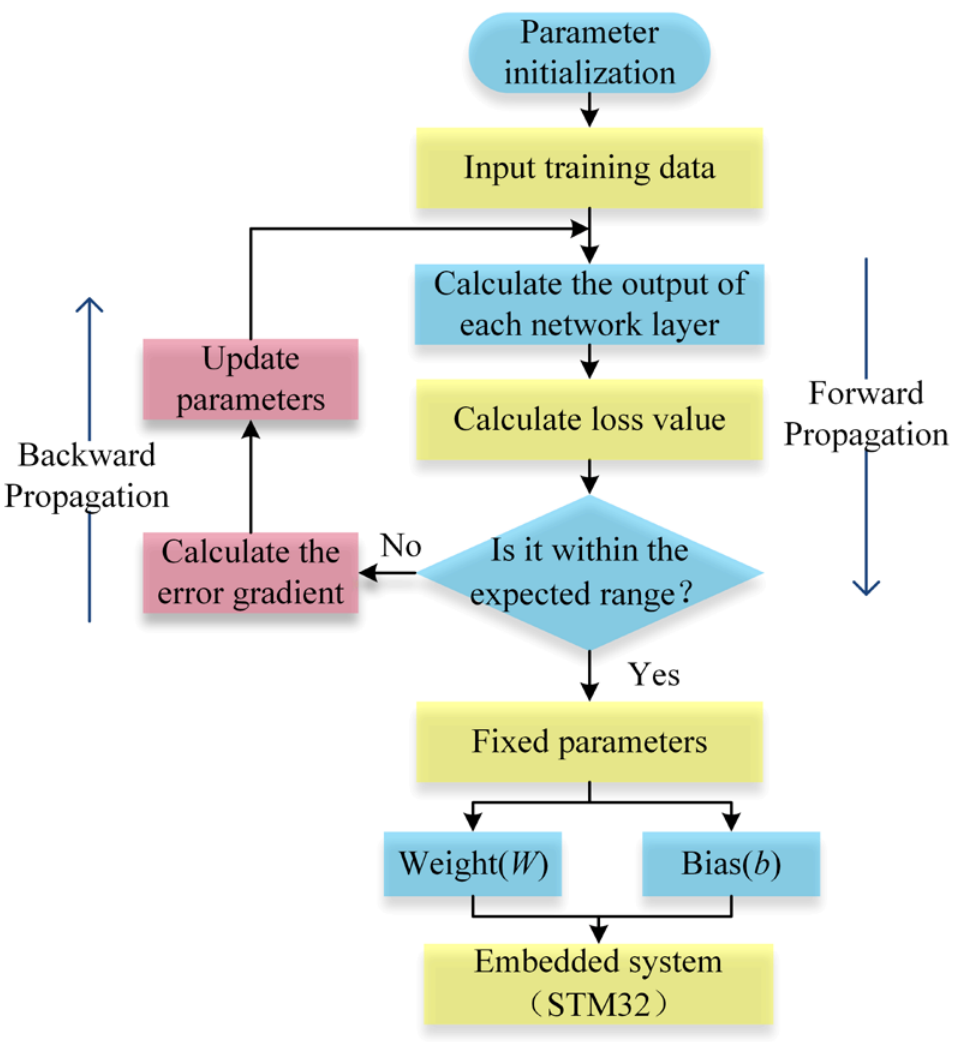
Figure 3. Parameter training and transplantation diagram for the proposed model.